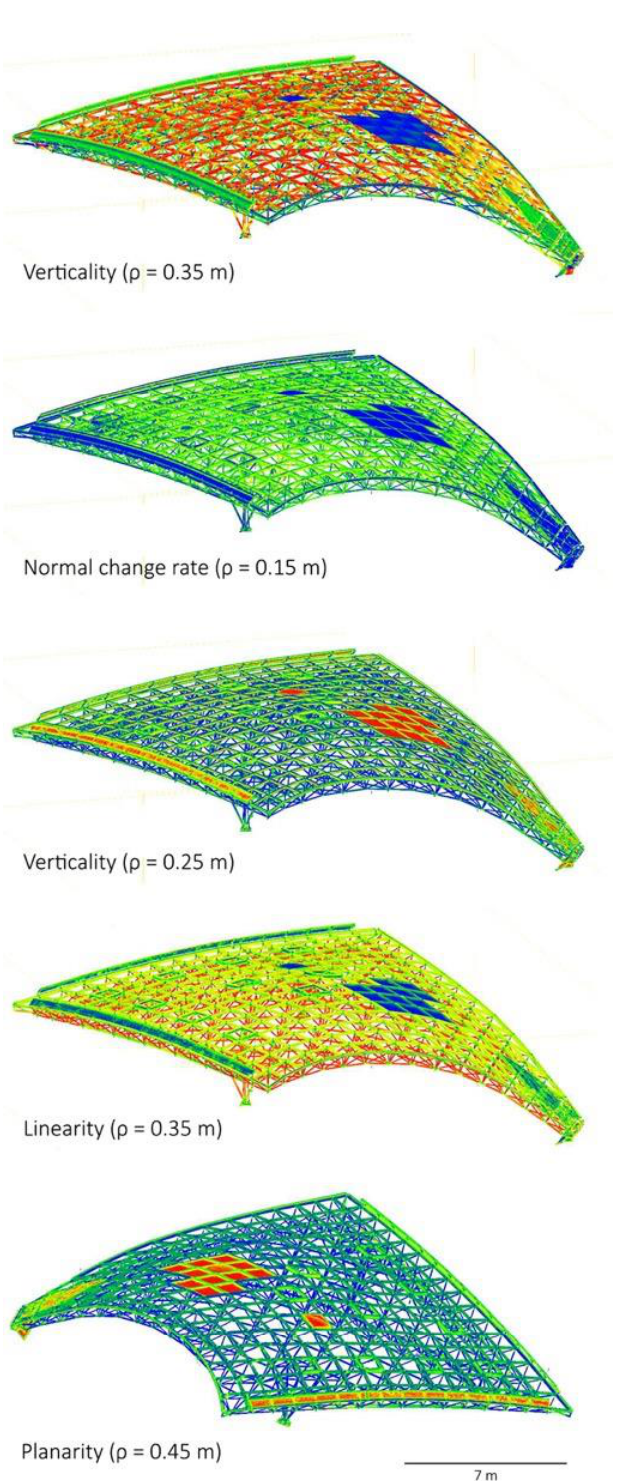
Figure A1. Many selected features for the ML-MR classification.